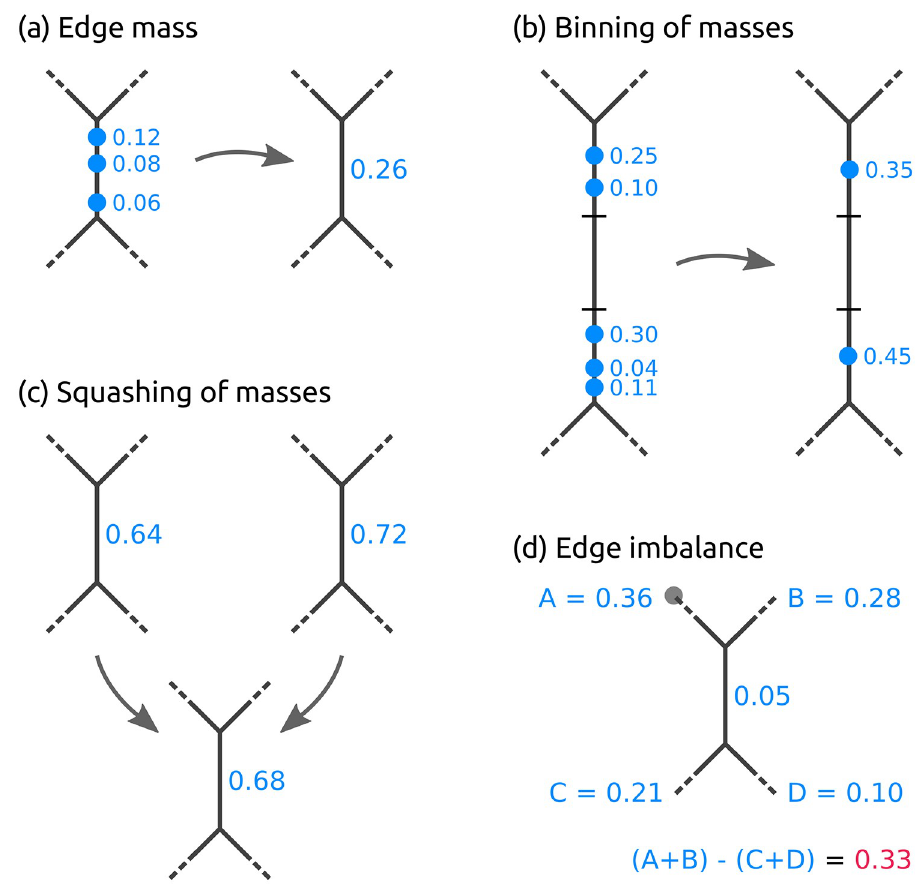
Fig 2. Operations on placement masses. (a) The edge mass or mass of an edge is the sum of likelihood weight ratios (LWRs) on that edge for all query sequences (QSs) in a sample. Here, three placements from three QSs on the branch are summarized. (b) In order to reduce time and memory of the computations, masses can be binned by summarizing them across QSs in intervals along the edges. (c) The masses on corresponding edges of the RT of two or more samples can be squashed to represent the average mass distribution of the samples. For simplicity, we here use equal weights, and show edge masses instead of individual LWRs. (d) The edge imbalance of an edge is the sum of masses on all edges on the root side of the edge ( A + B , with the root in subtree A denoted as a gray dot) minus the sum of the masses on the edges on the non-root side ( C + D ), while ignoring the mass on the edge